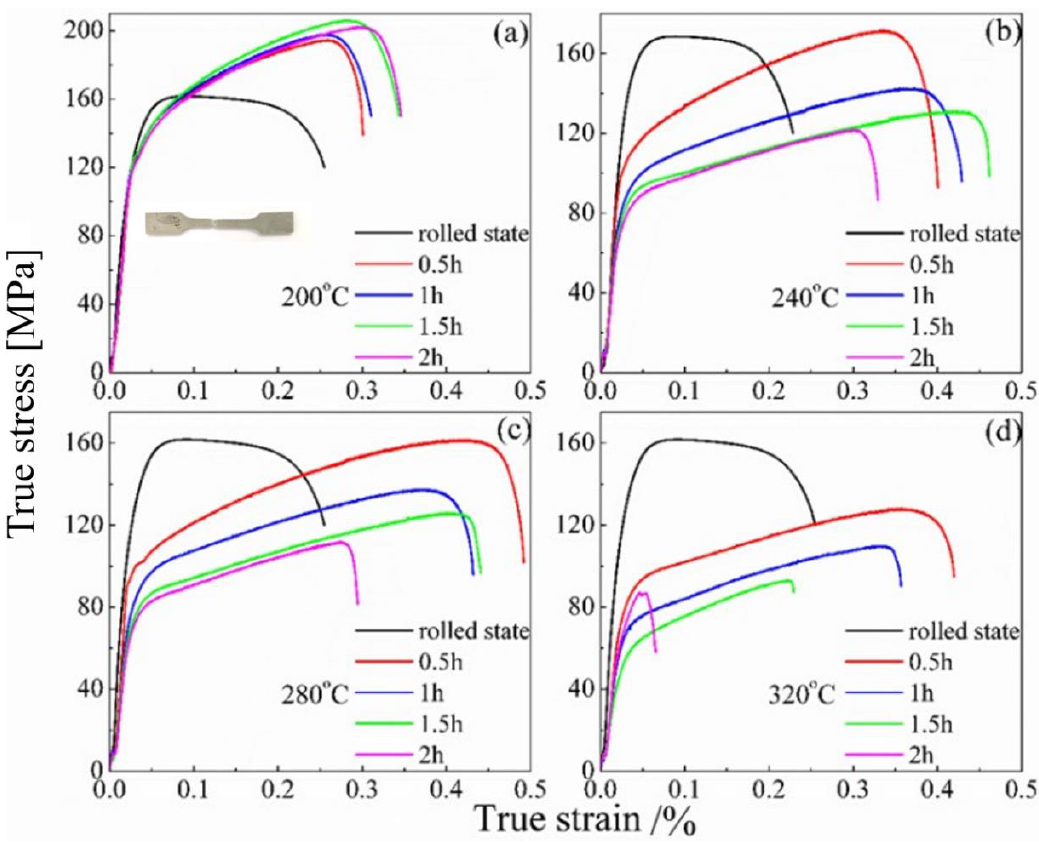
Figure 13. Ture stress-strain curves of Al/Zn composite plate, the illustration shows the macroscopic fracture morphology at 200 °C for 0.5 h. Table 4. Yield strength ( σ s ), tensile strength ( σ b ) and uniform elongation ( δ ) of Al/Zn laminate under different annealing conditions, Δσ b represents the difference in tensile strength between annealed and non-annealed.